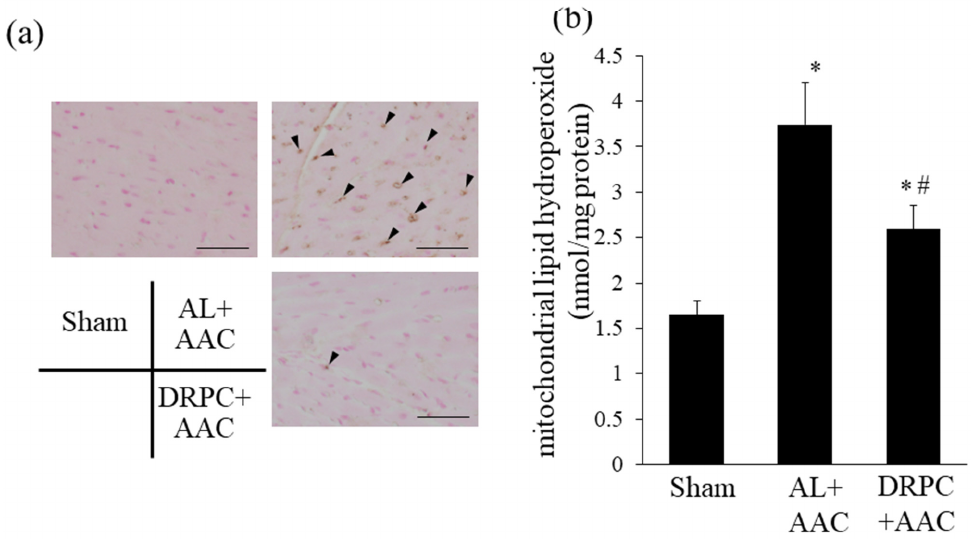
Figure 5. Effects of dietary restriction preconditioning on myocardial and mitochondrial oxidative stress in the left ventricle 2 weeks after surgery. ( a ) Representative photomicrographs of 8-hydroxy deoxyguanosine (8OHdG) immunostaining in the left ventricle. Arrowheads indicate 8OHdG-positive nuclei. Bars indicate 50 µ m ( n = 7). ( b ) Mitochondrial lipid hydroperoxide levels in the left ventricle. Lipid hydroperoxide levels were measured spectrophotometrically, as described in the Methods section (Sham: n = 7, AL+AAC: n = 6, DRPC+AAC: n = 5). * p < 0.05 versus Sham. # p < 0.05 versus AL+AAC.